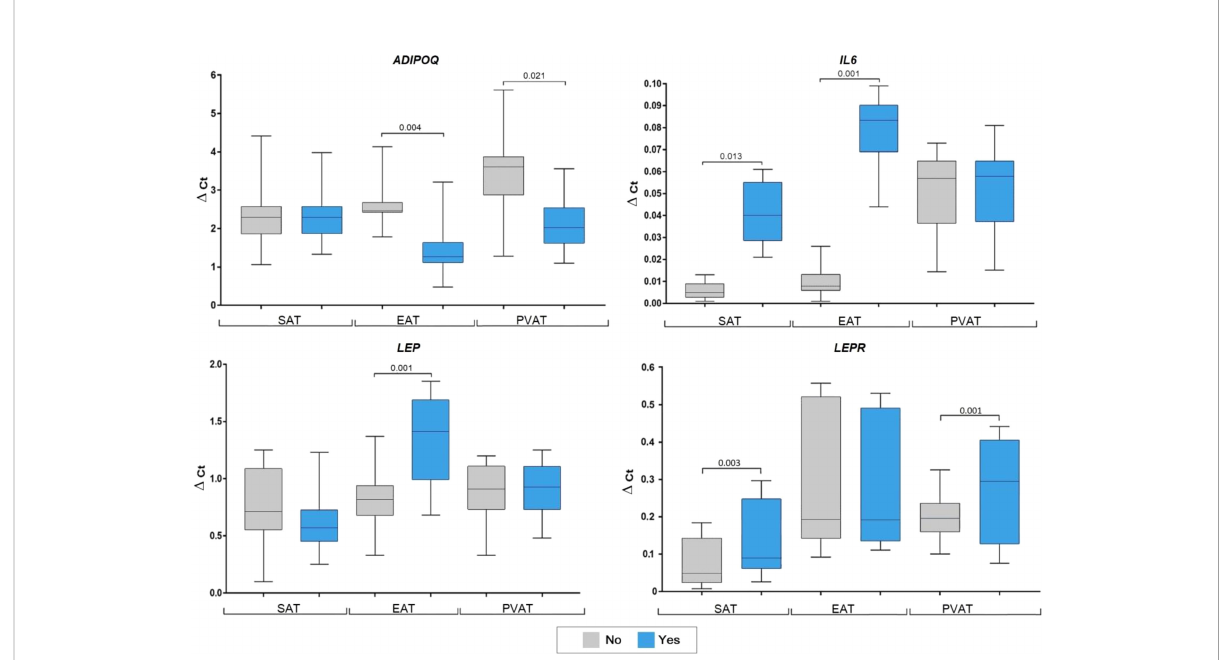
FIGURE 4 Adipocytokine gene expression in the adipocytes collected from adipose tissue based on arterial hypertension in coronary artery disease patients. Data are presented in Me (Q1; Q3). SAT, subcutaneous adipose tissue; EAT, epicardial adipose tissue; PVAT, perivascular adipose tissue; AH, arterial hypertension; p; level of statistical signi fi cance; sOB-R, soluble leptin receptor; IL6, in-terleukin 6.